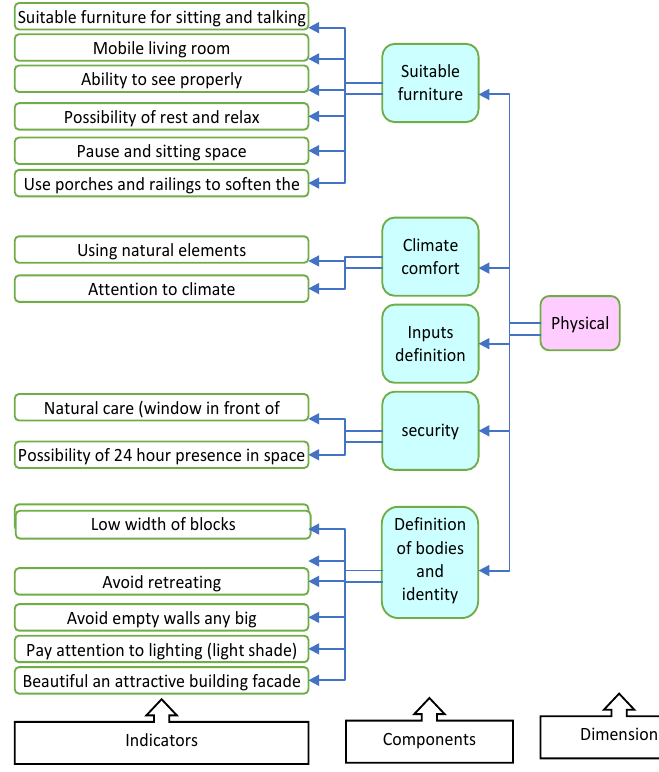
Fig. 5: Physical effective factoors on social interaction promotion